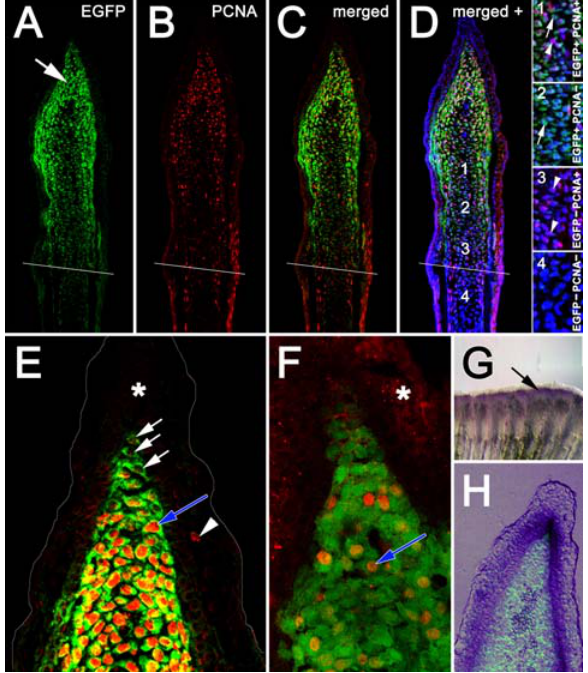
FIGURE 6. The ef1-a:EGFP transgene colabels with PCNA, BrdU, and msxc at 48 hpa. Confocal fluorescent images of a single cryosection from a Tg (ef1-a:EGFP) nt fin at 48 hpa demonstrate coimmunolocalization of EGFP and PCNA. (A) Immunolocalization of EGFP in the regenerating Tg (ef1-a:EGFP) nt fin is restricted to the mesenchyme, including the blastema (arrow). The location of the amputation plane is marked with a line. (B) PCNA immunolocalization (red) on the same section shown in panel A is also detected in the mesenchyme. (C) A merged image of panels A and B, reveals the large overlap of EGFP- and PCNA-positive cells. (D) The merged fluorescent image of panel C is colabeled with TO-PRO-3 (shown in blue), a nuclear stain. Numbers correspond to different regions containing different populations of cells that are shown in the insets on right. Panel 1 shows a mixed population of EGFP- (arrows) and PCNA-positive (arrowheads) cells. Panel 2 reveals a population of cells that are primarily only TO-PRO-3 and EGFP positive (arrows). Panel 3 shows a group of cells that are primarily TO-PRO-3 and PCNA positive (arrowheads). Panel 4 outlines a group of cells that are primarily TO-PRO-3 positive, but neither EGFP nor PCNA positive. (E) Close-up of a merged confocal image reveals EGFP and PCNA coimmunolabeling. The asterisk denotes the wound epithelium, which does not contain EGFP-positive cells. The distal-most blastema contains a few cells that are EGFP positive, but PCNA negative (white arrows). The proliferative blastema, just proximal to these cells, contains many cells that are EGFP and PCNA positive (blue arrow). A PCNA-positive cell in the wound epithelium (white arrowhead) is EGFP negative. (F) Confocal image of wholemount immunolabeling for BrdU (red) and EGFP expression from the Tg (ef1-a:EGFP) nt regenerating fin. The asterisk denotes the wound epithelium, which is EGFP negative. The blue arrow indicates one of the many BrdU- and EGFP-positive cells. (G) Wholemount in situ hybridization msxc expression in the regenerating Tg (ef1-a:EGFP) nt caudal fin. (H) Cryosection of the regenerating caudal fin shown in panel G demonstrating msxc expression relative to EGFP immunolocalization. Note that many EGFP-positive cells (green) colabel with msxc